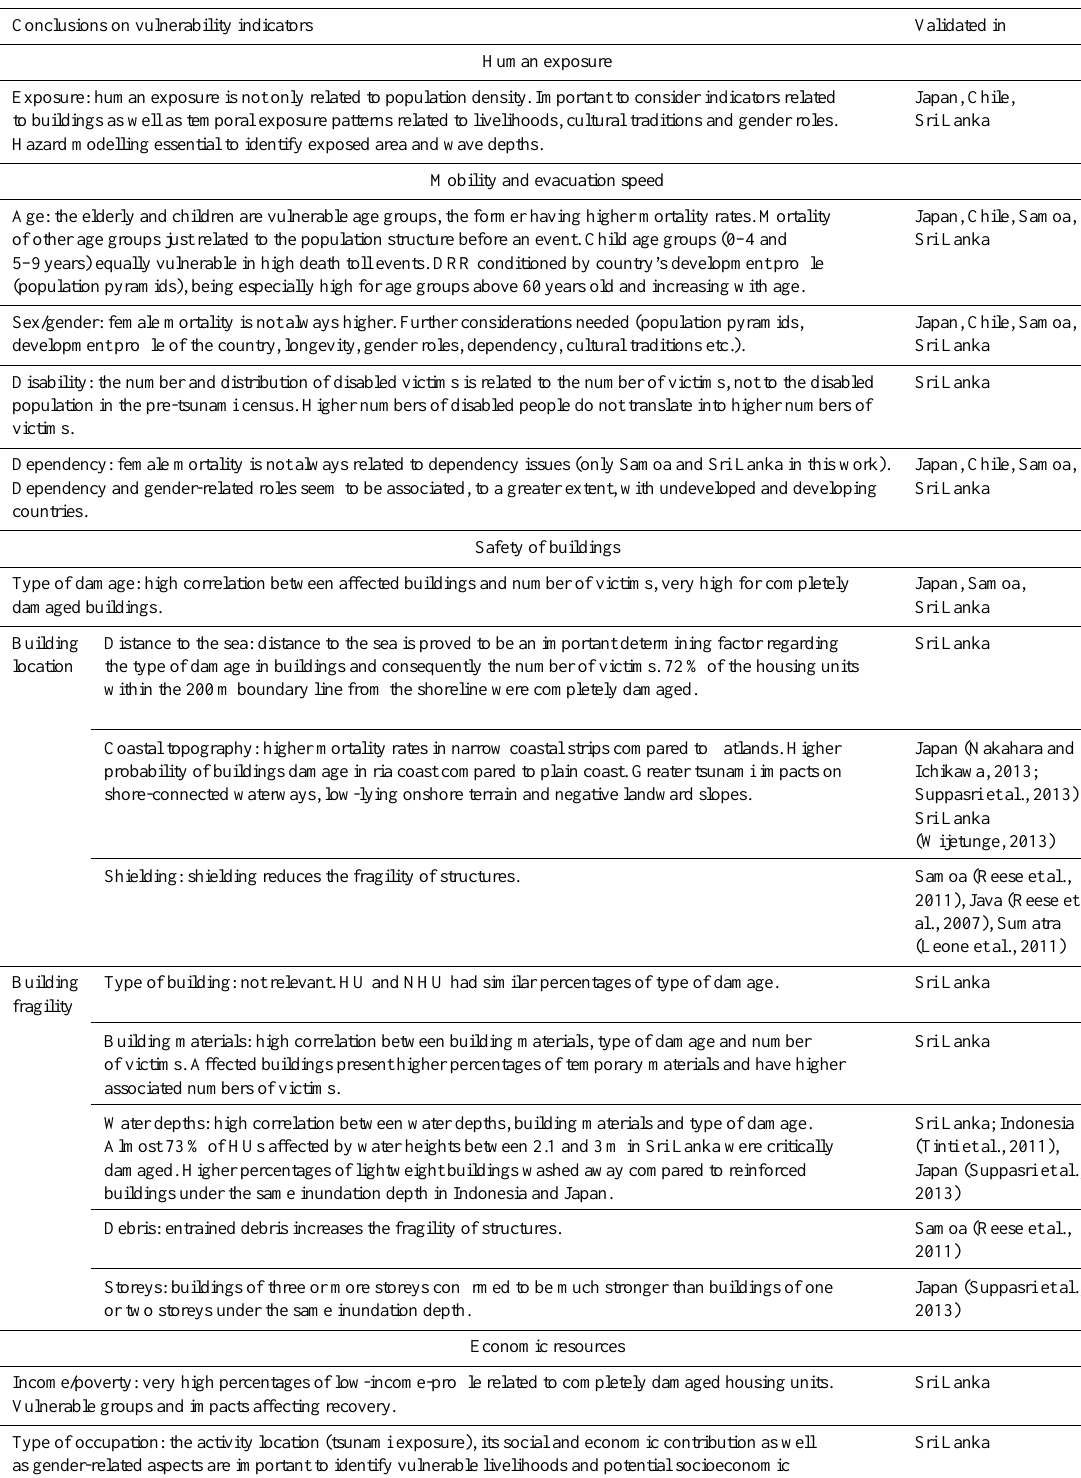
Table 5. Summary of the conclusions obtained on tsunami vulnerability indicators (where DRR is the death rate ratio, HU is the housing unit and NHU is the non-housing